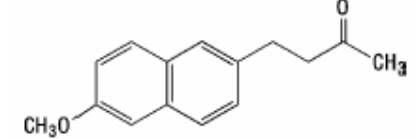
Figure 1. Chemical structure of nabumetone